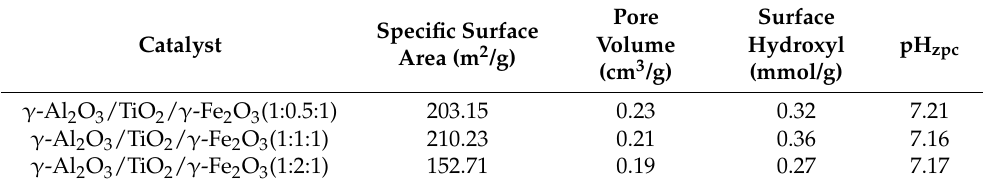
Table 1. Specific surface area, pore volume, pore size, surface hydroxyl, and pH zpc of the catalyst.